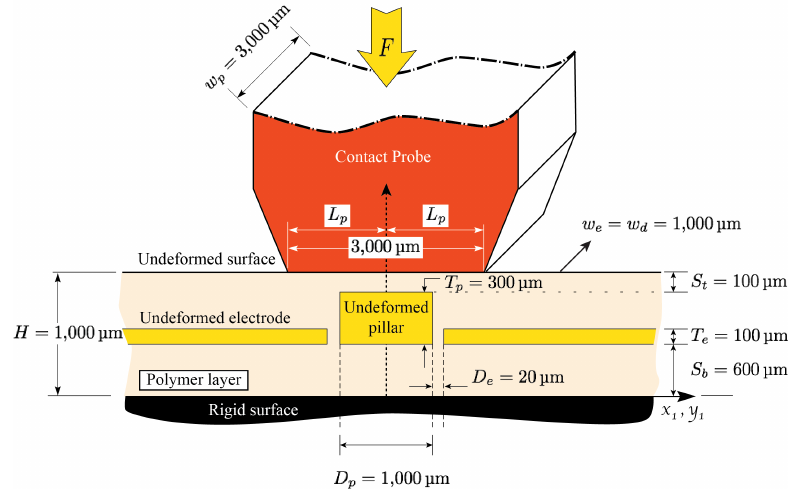
Figure 5. A detailed geometry of the tactile unit-sensor designed and fabricated in